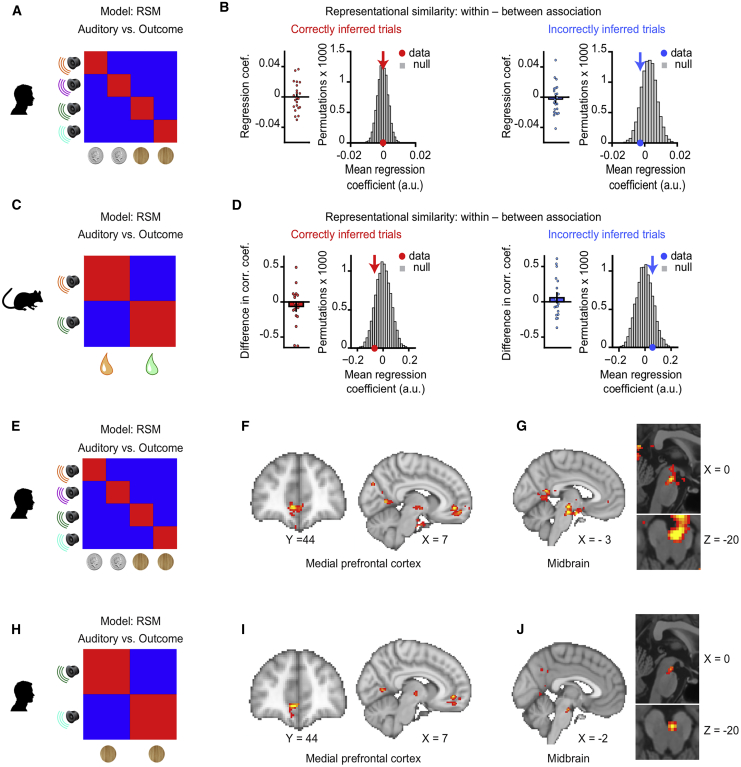
Inferred Outcomes Are Represented in mPFC and Midbrain(A–D) In humans (A and B) and mice (C and D) hippocampal activity patterns during auditory cues Xn in the inference test were compared with activity patterns during outcome Zn in conditioning using RSA. In mice, time bins with SWRs were excluded. Activity patterns during Xn in the inference test, but not Zn in conditioning, were filtered by the “decision point” on each trial, such that representations of Zn were spatially decoupled from representations of Yn. Hippocampal activity in humans and mice did not significantly predict activity associated with the relevant outcome Zn ([average within association XnZn correlations, RSM main diagonal] – [average between association XnZm correlations, RSM off-diagonals]; correct and incorrect inference; humans, conditional on intermediary cues: Z21 = −0.06, p = 0.526, and Z21 = −0.75, p = 0.772; mice: Z17 = −0.87, p = 0.808; and Z17 = 0.44, p = 0.331; mean ± SEM), including when comparing the group mean against a null distribution generated by permuting the identity labels for cues Xn (correct and incorrect inference; humans: p = 0.464, and p = 0.868; mice: p = 0.829 and p = 0.176). See Figure S6C for results in humans unconditional on intermediary cues. By contrast, robust dCA1 representation of Zn was observed in mice during experience of outcome Zn in conditioning trials (Figure 3).(E–J) In humans, searchlight RSA with multiple regression (Figures S6D and S6E) was used to identify regions showing representational similarity between auditory cues Xn in the inference test and outcomes Zn in conditioning. During correctly inferred cues Xn, both the mPFC (F) and putative dopaminergic midbrain (G) regions showed significant representation of the associated Zn, conditional on sensory cues that predicted the outcome as shown in the model RSM in (E) (F, mPFC: t21 = 5.09, p = 0.003; G, midbrain: t21 = 5.56, p < 0.001; thresholded at p < 0.01 uncorrected for visualization purposes only). This result held for cues in set 2 as shown in the model RSM in (H) (I: mPFC: t21 = 4.60, p = 0.006; J, midbrain: t21 = 3.37, p = 0.027; peak-level FWE corrected using small-volume correction; Figures S6F and S6G; thresholded at p < 0.01 uncorrected for visualization purposes only).See also Figure S4 and Tables S3 and S4.